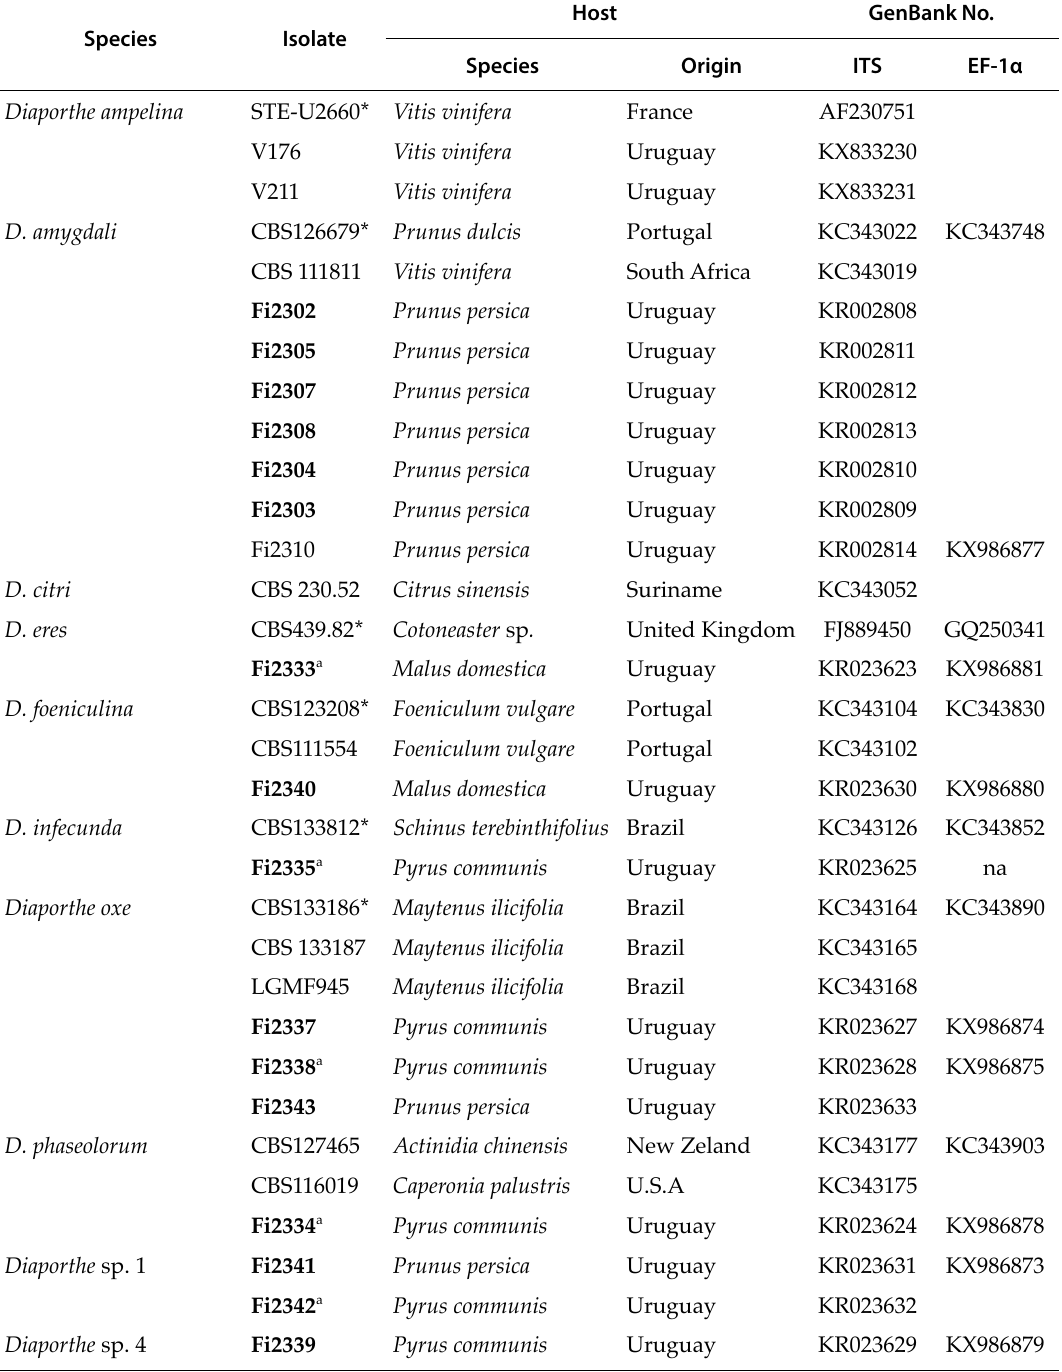
Table 2. Isolates of Diaporthe spp. recovered in this study, their host origins, and species obtained from GenBank included in the phylogenetic analyses of this